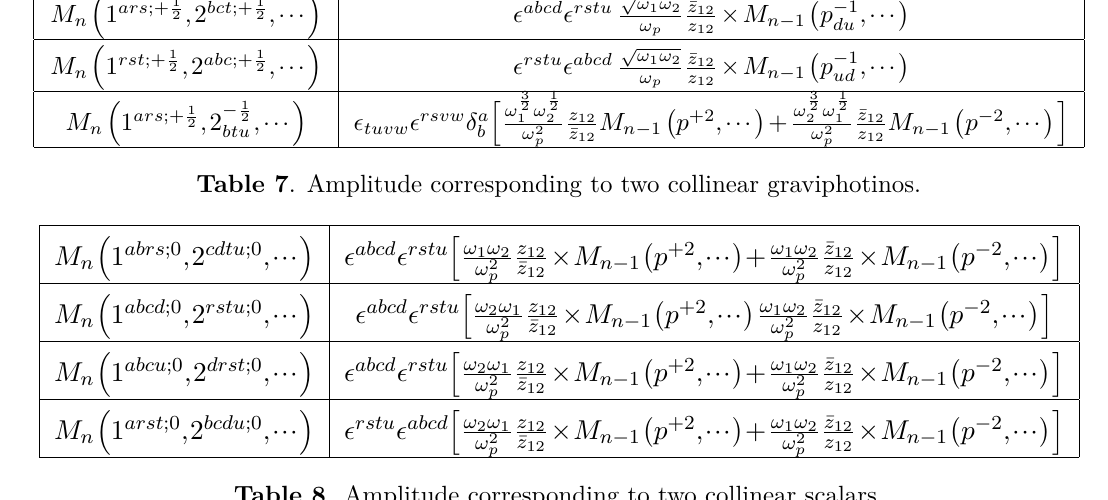
Table 8 . Amplitude corresponding to two collinear